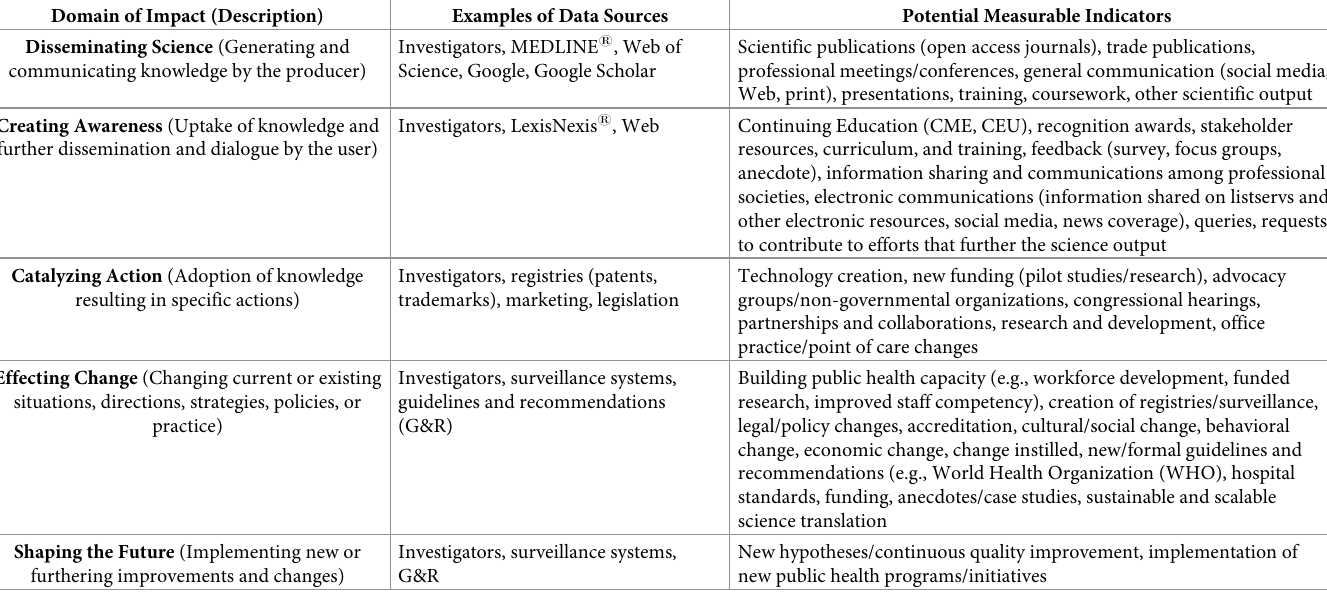
Table 2. The science impact framework–Examples of indicators and data sources � . Domain of Impact (Description)